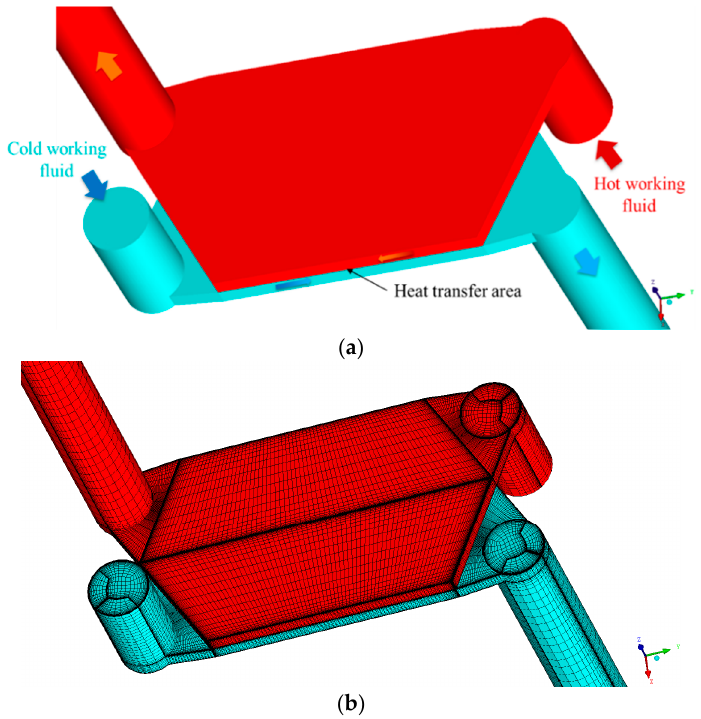
Figure 3. Heat transfer unit in the heat exchangers 1 and 2: ( a ) sketch and ( b ) computation grids.